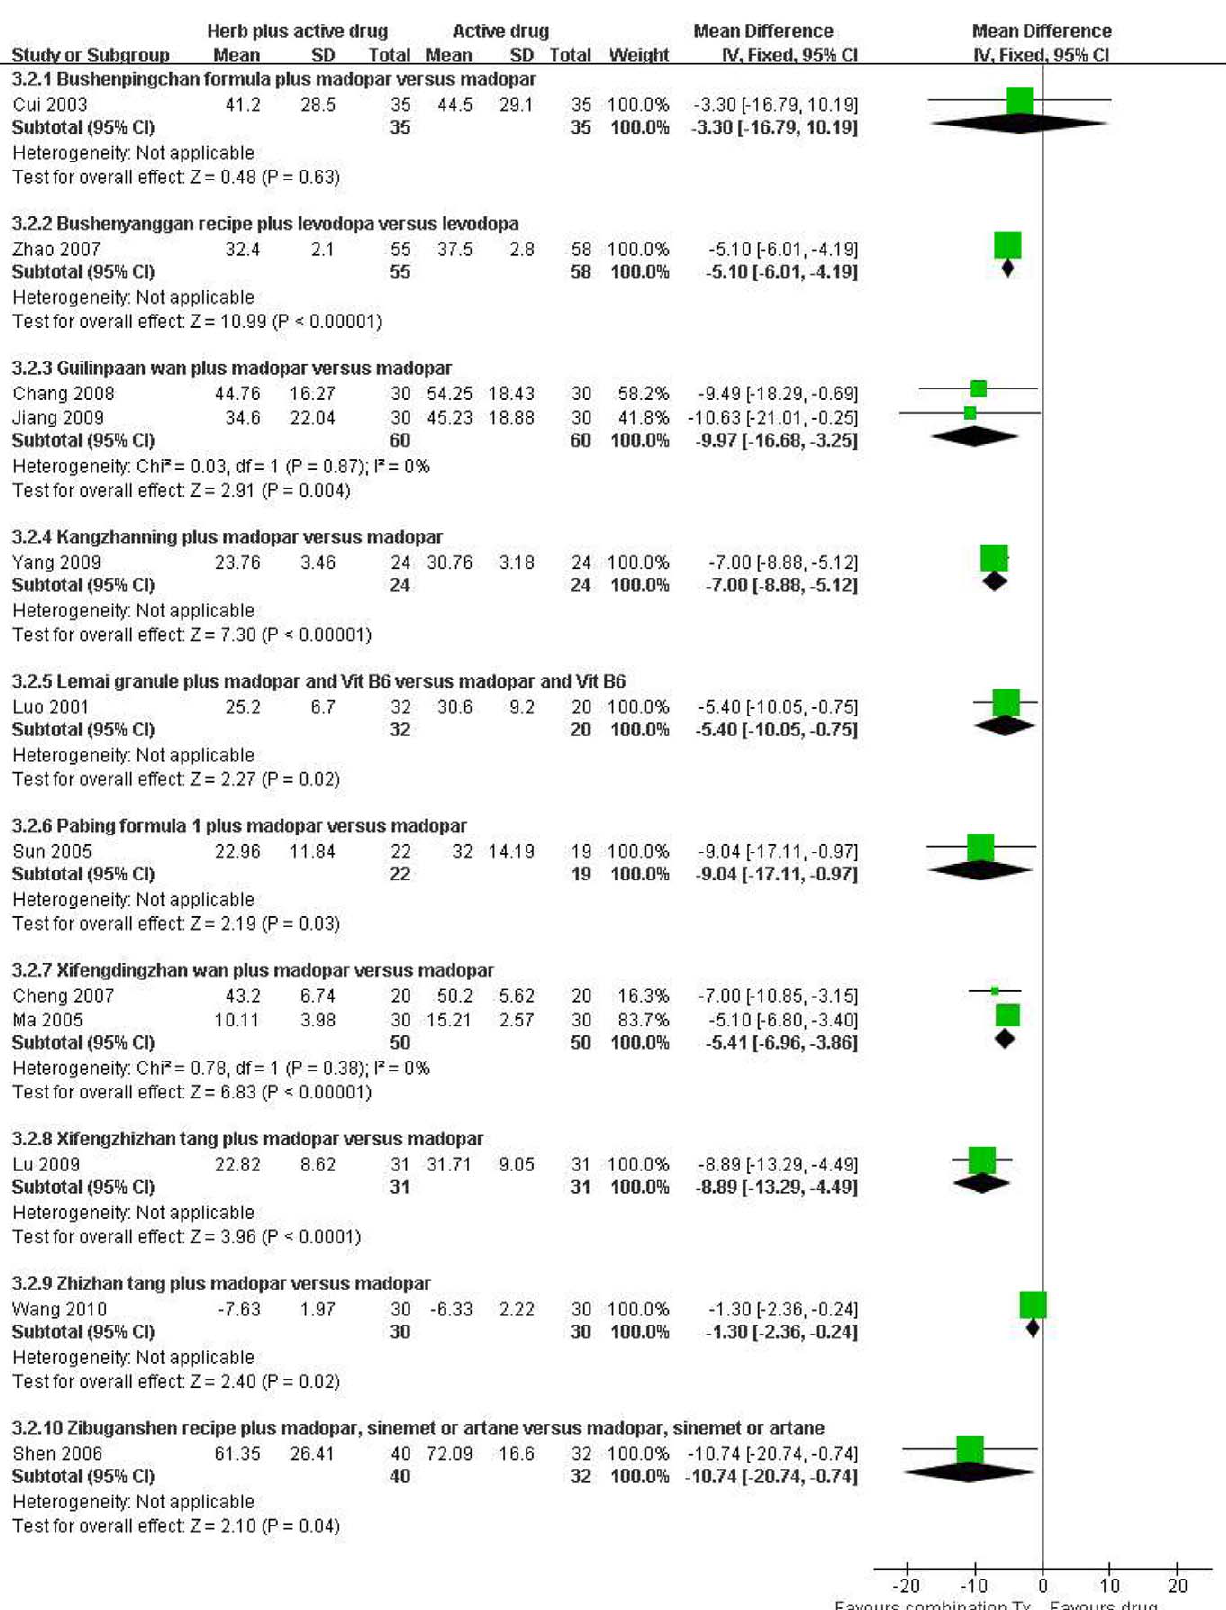
Figure 3. Herbal medicine plus active drug versus active drug, total UPDRS score.